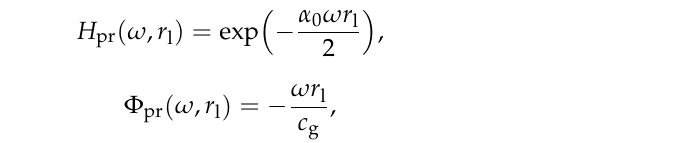
Figure 5. Seismic wave propagation in the local site (plan view).